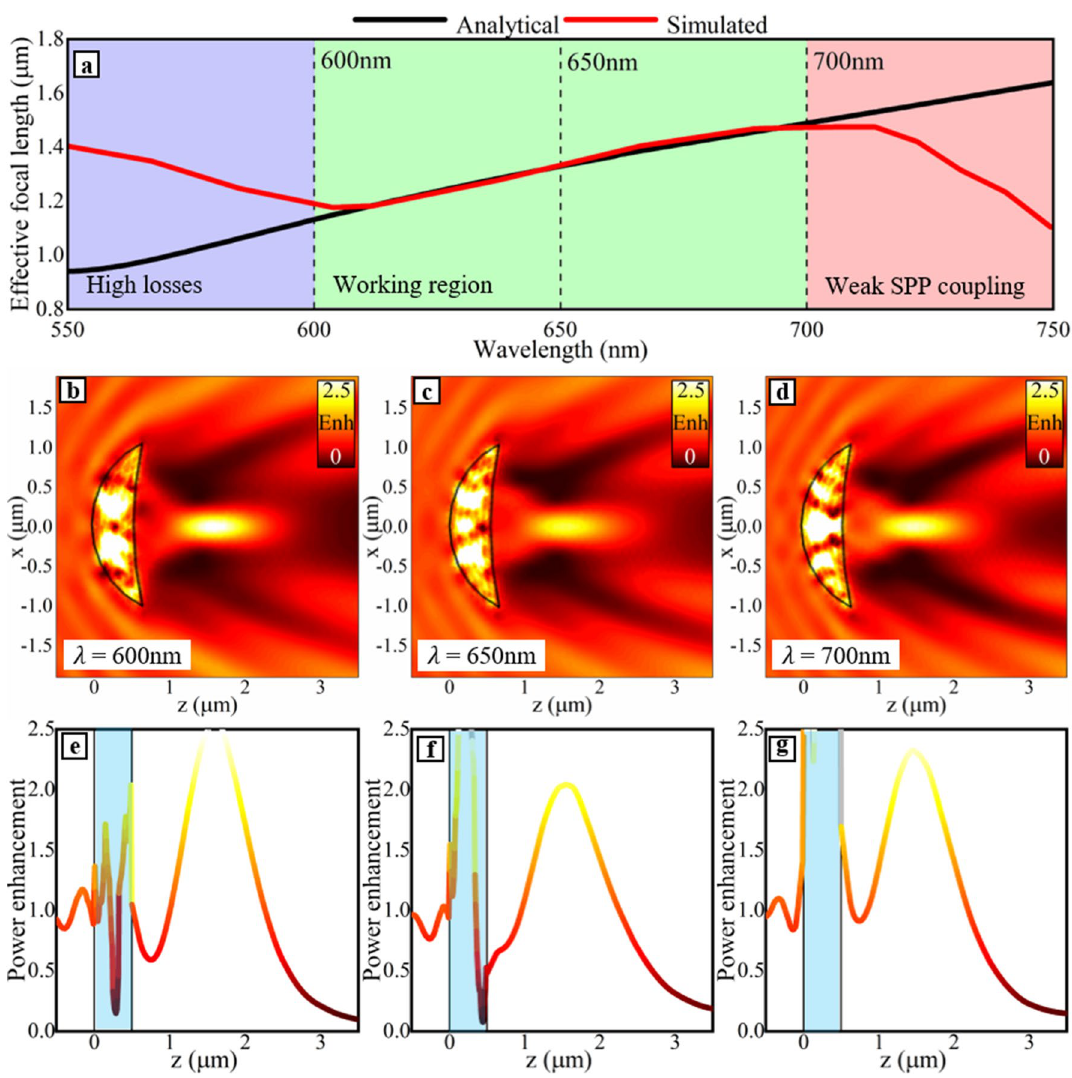
Figure 5. ( a ) Theoretical (black) and numerical (red) results of the EFL as a function of the incident illumination wavelength for the 3D plasmonic meniscus lens discussed in Fig. 4f designed at R 1 = 1266 nm, R 2 = 4046 nm, t = 500 nm, and an EFL = 1266 nm. The blue region (λ between 550 and 600 nm) represents a spectral band where the meniscus lens suffers from high losses, the green region (λ between 600 and 700 nm) represents where the lens maker equation functions as expected , and the red region (λ between 700 and 750 nm) represents where the lens suffers from a weak coupling of SPPs. Power enhancement on the xz -plane at the surface of the metal ( y = 0) for the case described previously for a wavelength of ( b ) 600 nm ( c ) 650 nm and ( d ) 700 nm. Power enhancement on the surface of the metal ( y = 0) for a wavelength of ( e ) λ = 600 nm, ( f ) λ = 650 nm and ( g ) λ = 700 nm along the z -direction at the centre of the lens ( x = 0). The blue boxes show the position of the lens along the z -direction at the centre of the lens ( x = 0). The scale bars seen in ( b )–( d ) also refer to colouring in ( e )–( g